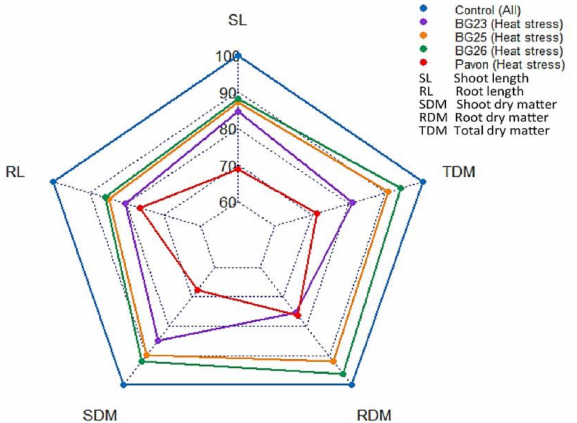
Figure 1. Radar plot showing changes in various morphological traits in different wheat varieties caused by heat stress. The values are expressed as % of the control.